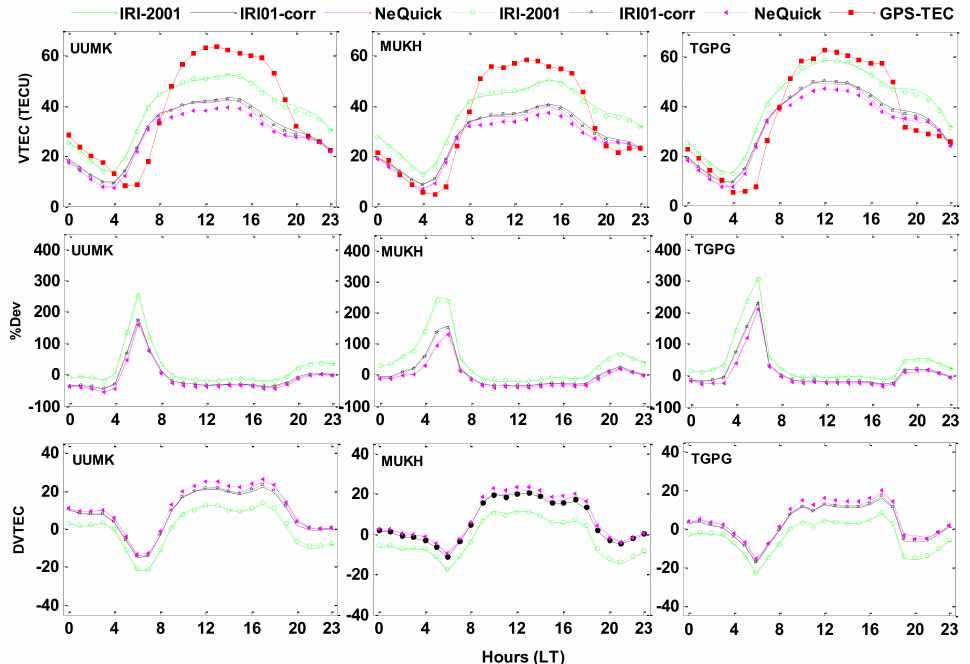
Figure 10. The hourly diurnal variation during the geomagnetic storm on 18 March 2013 ( top panel), percentage deviation ( middle panel), and the DVTEC ( bottom panel) of IRI-2016 and IRI-2012 topside options over UUMK, MUKH, and TGPG stations. IRI-2016 (IRI-2001, IRI01-corr, and NeQuick) are plotted in solid lines and the IRI-2012 (IRI-2001, IRI01-corr, and NeQuick) are plotted in dotted